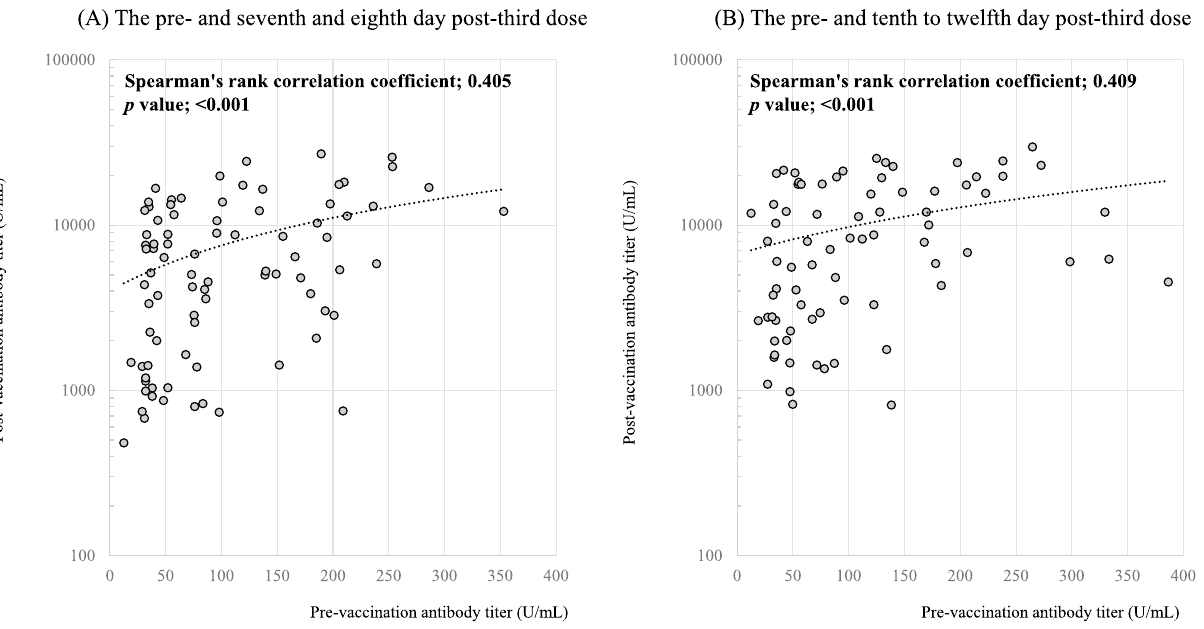
Figure 3. Correlation between the pre- and post-third dose of the vaccine. ( A ) The pre- and seventh and eighth day post-third dose. ( B ) The pre- and tenth to twelfth day post-third dose. The antibody titers were measured by fingertip whole blood sampling test. Weak positive correlations were observed between the pre- and post- booster in both